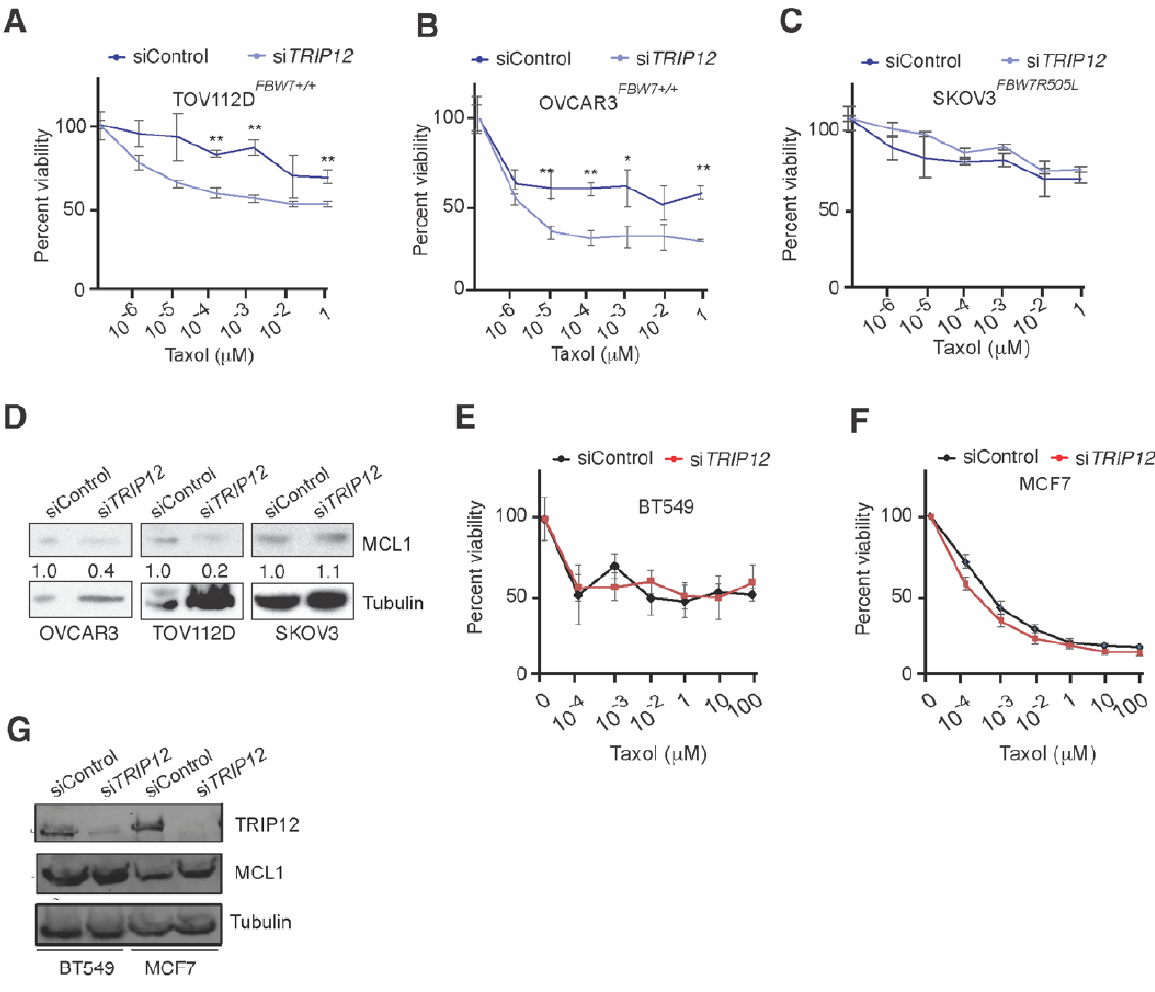
Figure 6. Analyzing the role of TRIP12 inhibition in sensitizing ovarian and breast cancer cells to Taxol. ( A – C ) Cell titer blue viability assay quantification in ovarian cancer cells of indicated geno–types treatment with indicated doses of Taxol. ( D ) Western blot for indicated antibodies in ovarian cancer cells incubated with siControl or si TRIP12 . Numbers under the MCL1 blot represents densitometric quantification normalized to loading control α -Tubulin. ( E , F ) Cell titer blue viability assay quantification in breast cancer cells treated with indicated doses of Taxol. ( G ) Western blot for indicated antibodies in ovarian cancer cells incubated with siControl or si TRIP12 . Note: * = p < 0.05 and ** = p < 0.01.